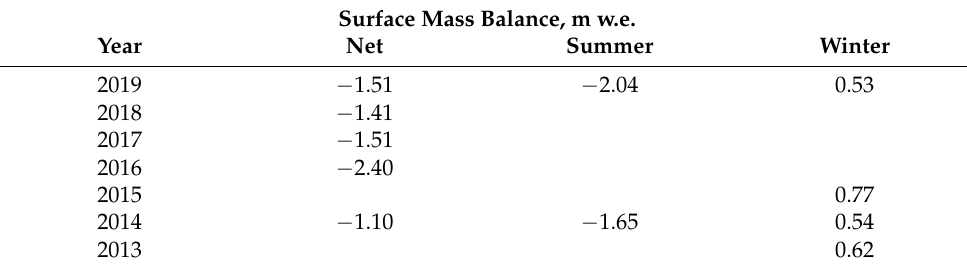
Table 4. Surface mass balance of Austre Grønfjordbreen. Surface Mass Balance, m w.e.